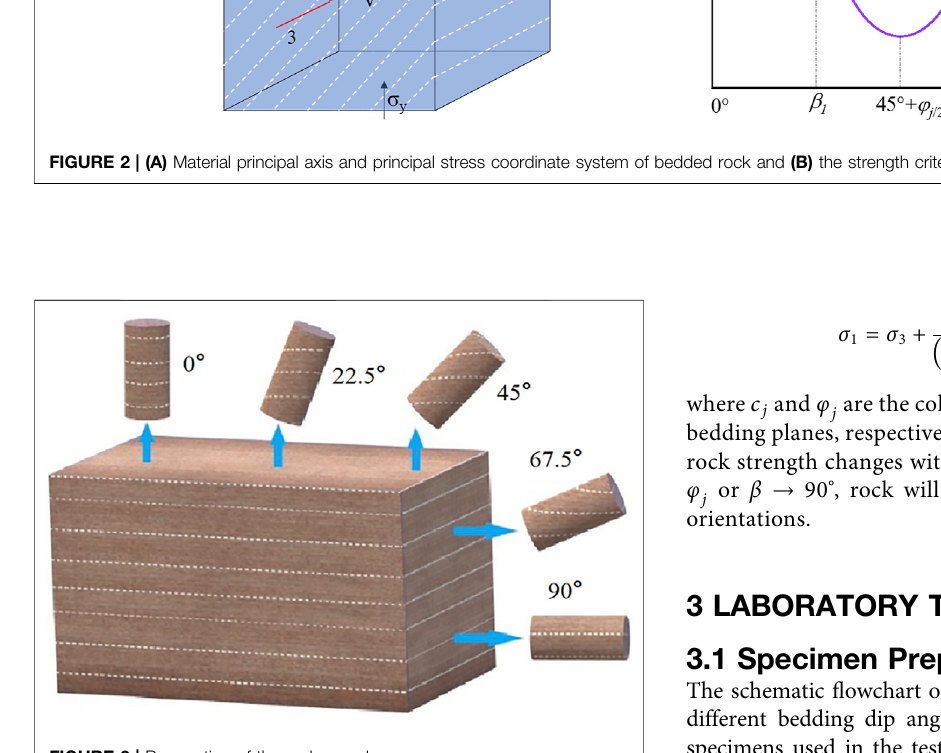
FIGURE 3 | Preparation of the rock